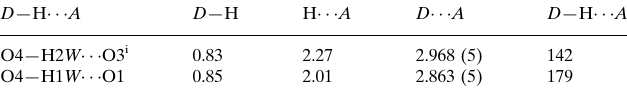
Hydrogen-bond geometry (A˚ , (cid:4) ). D —H (cid:1)(cid:1)(cid:1)